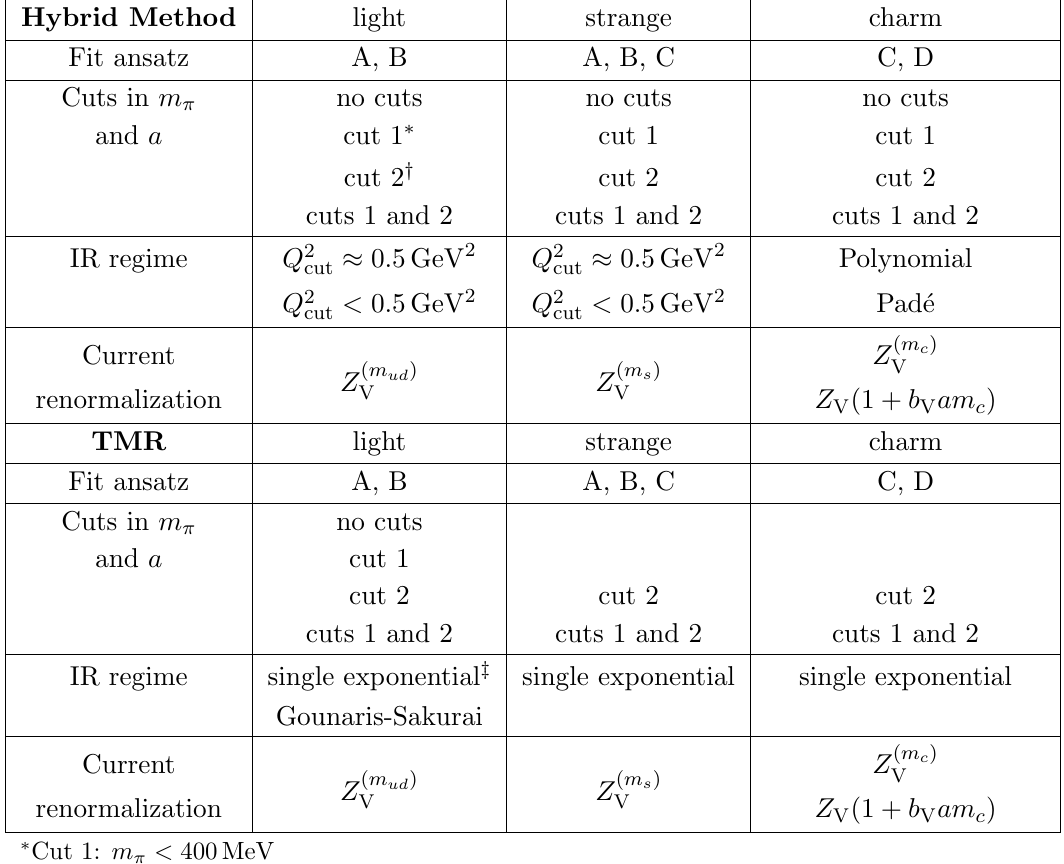
Table 6 . Overview of variants of the (cid:12)tting and analysis procedures which enter the estimation of systematic errors via the extended frequentist method. We focus on the hybrid method with the low- Q 2 behaviour determined by (cid:12)ts, as well as the TMR. The meaning of the various cuts is explained below the